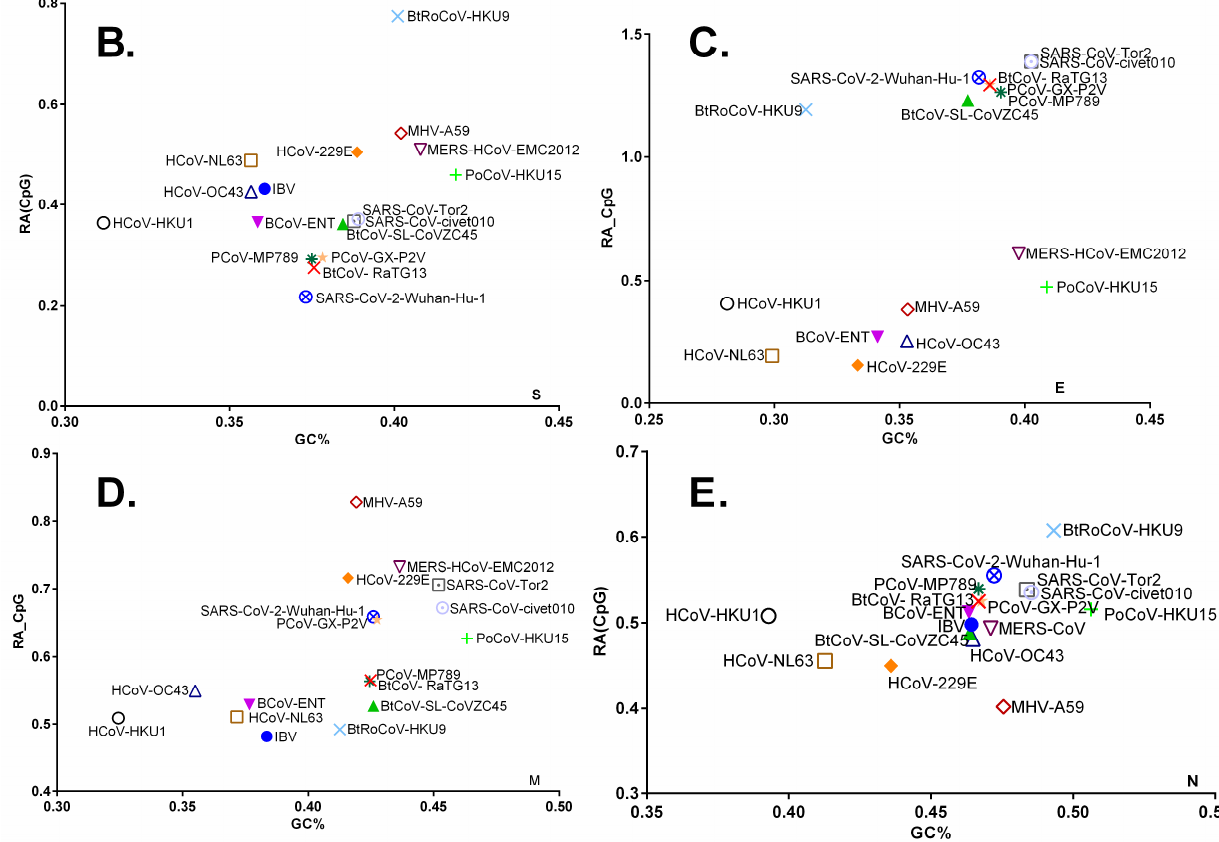
Figure 6. A plot of virus genomic RA CpG against GC% in the entire coding genomic sequences ( A ), spike ( B ), envelope ( C ), membrane ( D ), and nucleocapsid ( E ) encoding sequences of CoVs infecting diverse hosts.